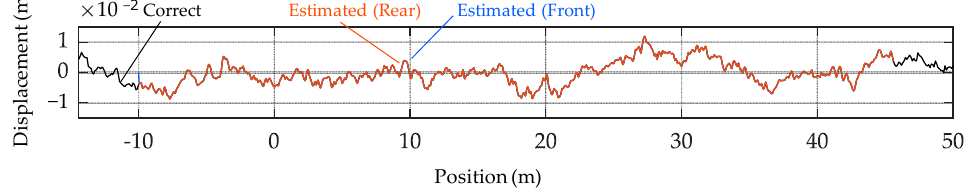
Figure 12. The estimated road unevenness R ( x ) : the estimated road unevenness ˆ R 1 ( x ) and ˆ R 2 ( x ) shown in this figure are calculated using the optimal particle 𝑿 (cid:3029)(cid:3032)(cid:3046)(cid:3047)((cid:2874)(cid:2868)(cid:2868)) minimizing 𝐽 in Scenario 6.